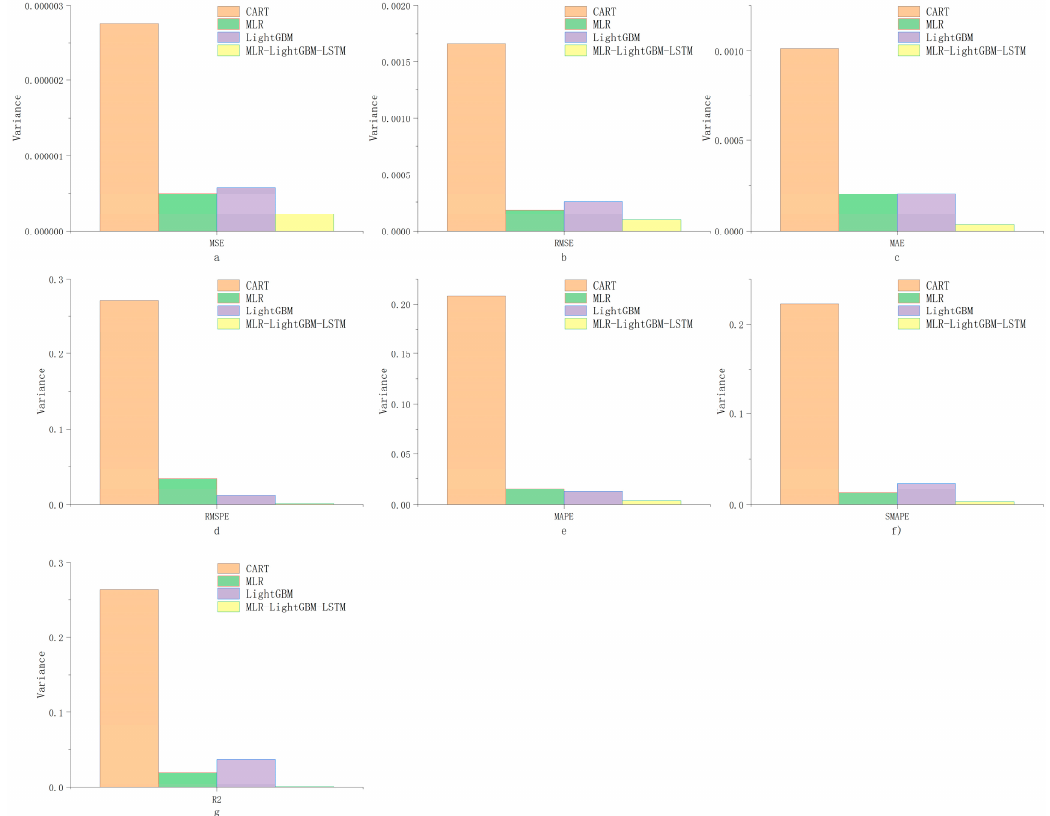
Figure 22. Model variance comparison (a-g are seven different evaluation metrics.). Table 5 Model bias comparison (based on the training set).